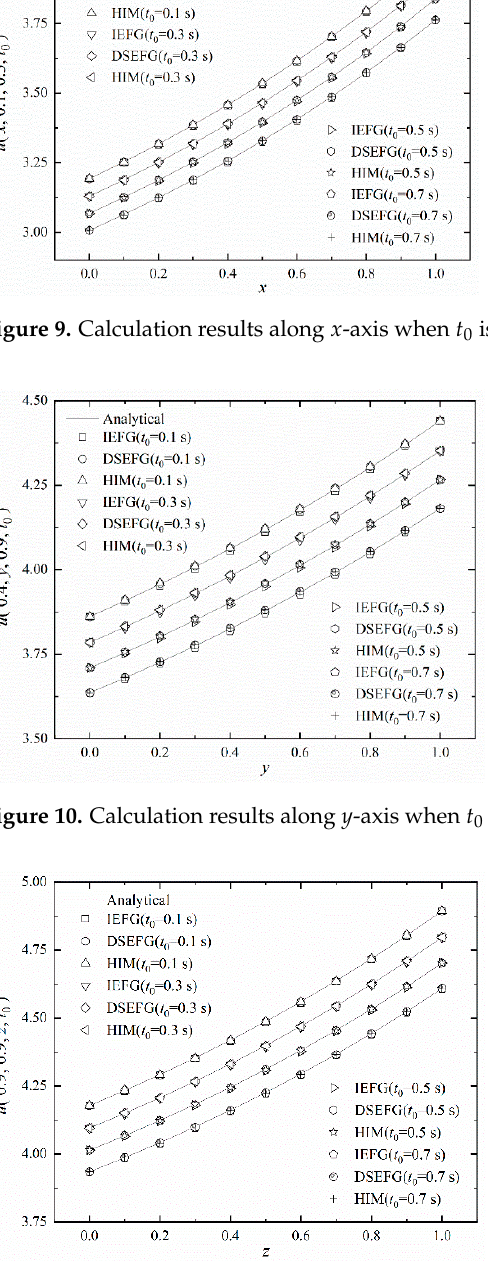
is different. is different. 0 0